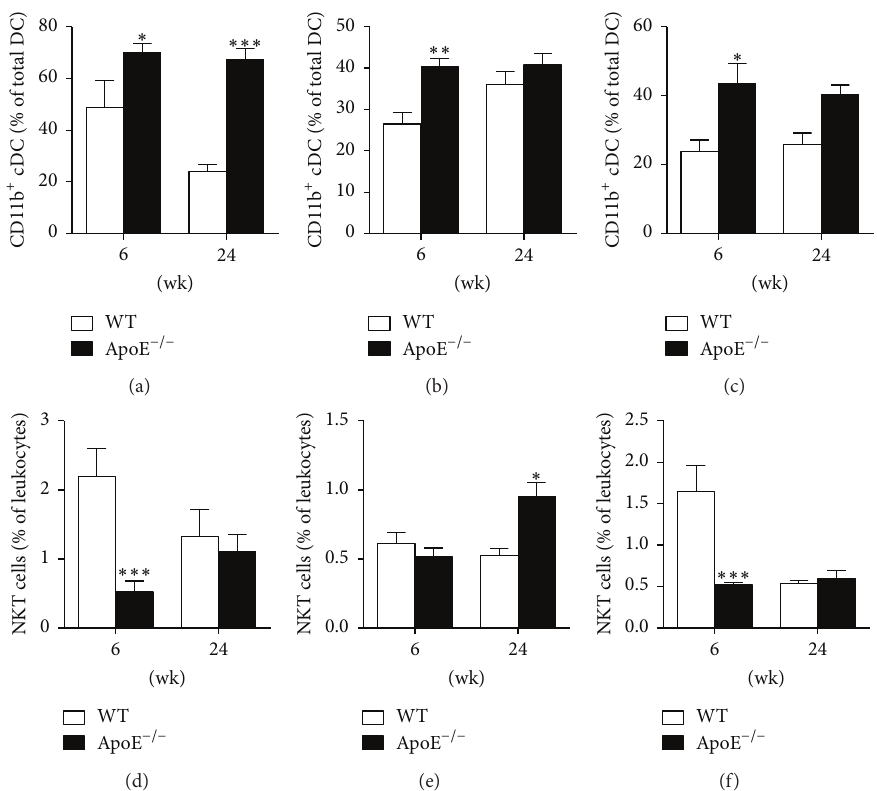
Figure 4: Comparison of CD11b + cDC and NKT cell fluctuations between ApoE −/− mice and age-matched healthy controls. (a–c) Percentages of circulating CD11b + cDC in blood (a), spleen (b), and mediastinal LN (c) of ApoE −/− mice fed a WD and healthy wild-type controls fed a chow diet sacrificed at 6 and 24 wk of diet. (d–f) Circulating NKT cell numbers in blood (d), spleen (e), and mediastinal LN (f) of ApoE −/− mice fed a WD and healthy wild-type controls (on chow diet) sacrificed at 6 and 24 wk of diet. WT (white bars), 𝑛 = 4 – 6 ; ApoE −/− (black bars), 𝑛 = 9 – 12 ; ∗ 𝑃 < 0.05 , ∗∗ 𝑃 < 0.01 , and ∗∗∗ 𝑃 < 0.001